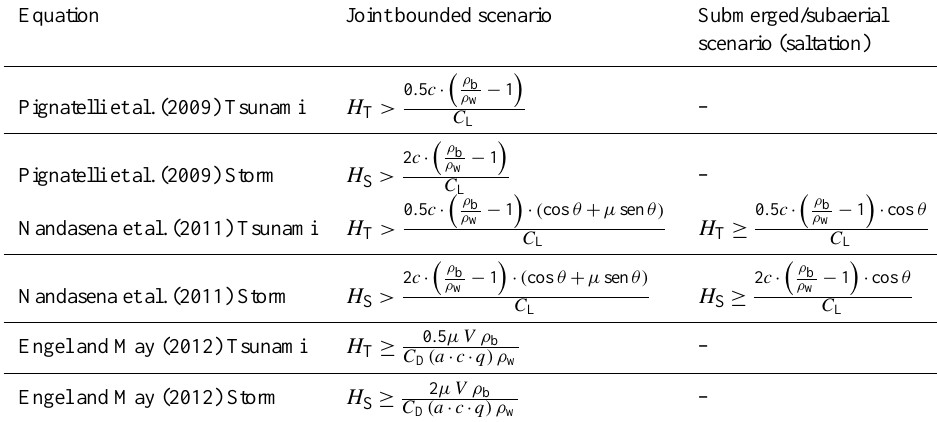
Table 1. Hydrodynamic equations (a, b and c for major, medium and minor axis respectively; ρ b is the boulder density; ρ w is the sea water density; C L is the lift coefficient, which is 0.178; θ is the bed slope angle; µ is the coefficient of static friction, which is 0.65; V is the boulder volume; C D is the coefficient of drag, which is 1.95; q is the boulder area coefficient, which is